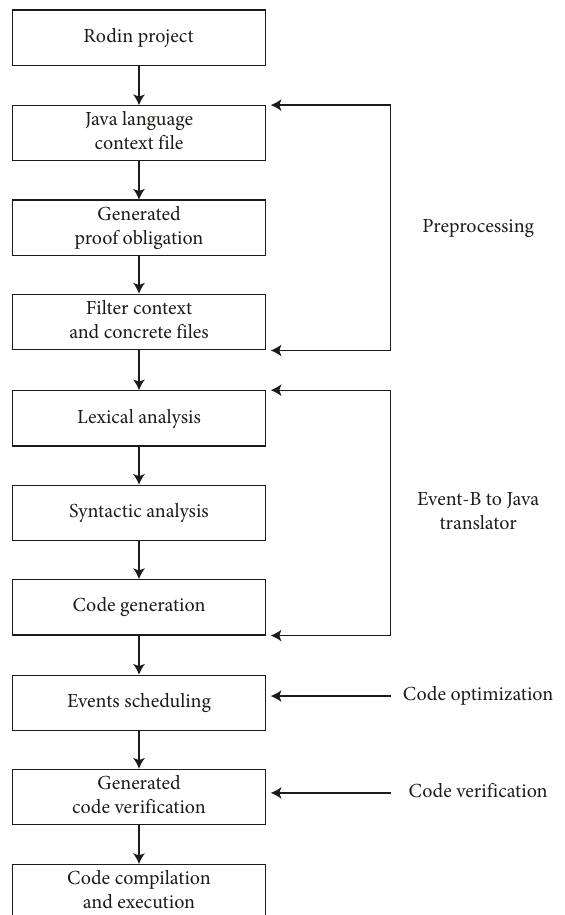
Figure 2: The EB2J tool architecture